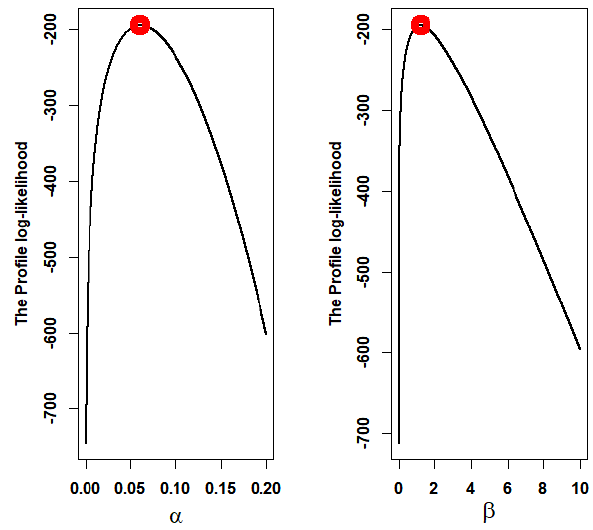
Figure 5. The profile log-likelihood plot for the third data set.